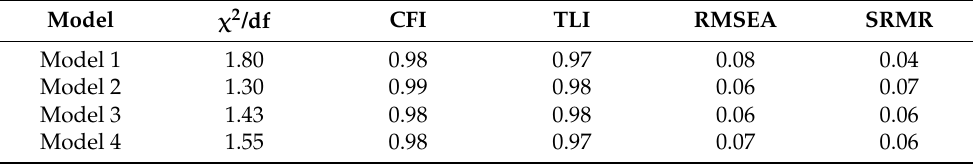
Table 2. Model fit indices in multigroup model